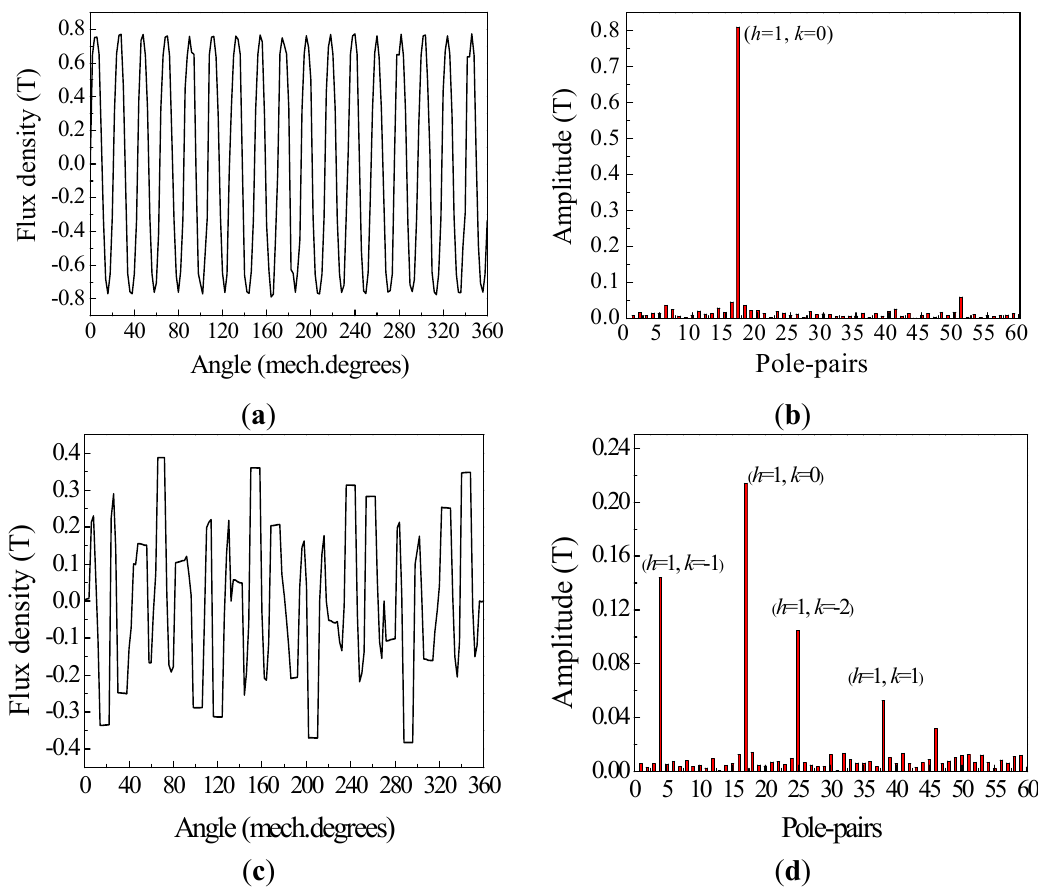
Figure 3. Axial flux density waveforms due to the permanent magnet rotor, in the air gap adjacent to the stator and corresponding space harmonic spectra: ( a ) axial flux density waveform without the modulating ring rotor; ( b ) the space harmonic spectrum without the modulating ring rotor; ( c ) axial flux density waveform with the modulating ring rotor; and ( d ) the space harmonic spectrum with the modulating ring rotor.